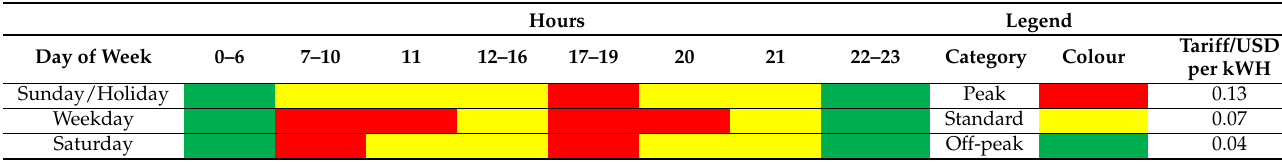
Table 5. Time of use periods and corresponding